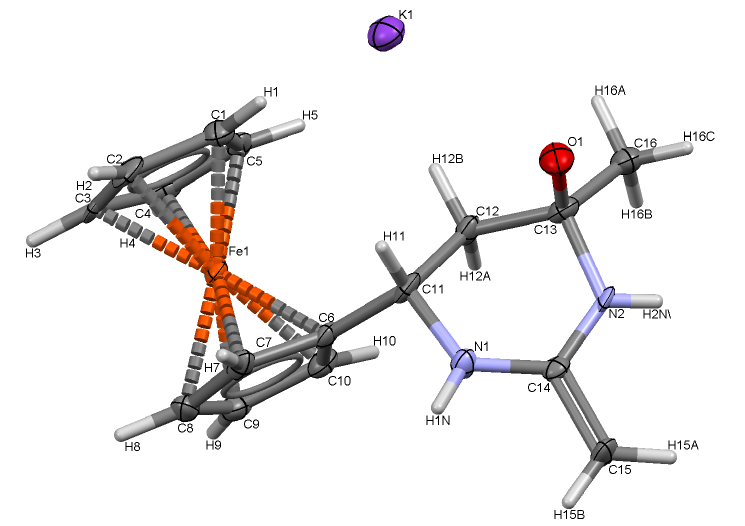
Figure 2. X-ray crystal structure of 7